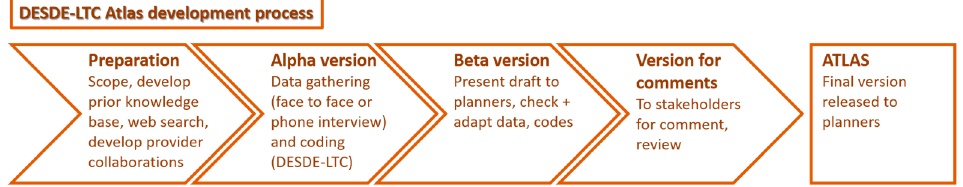
Figure 1. DESDE-LTC Atlas development process.